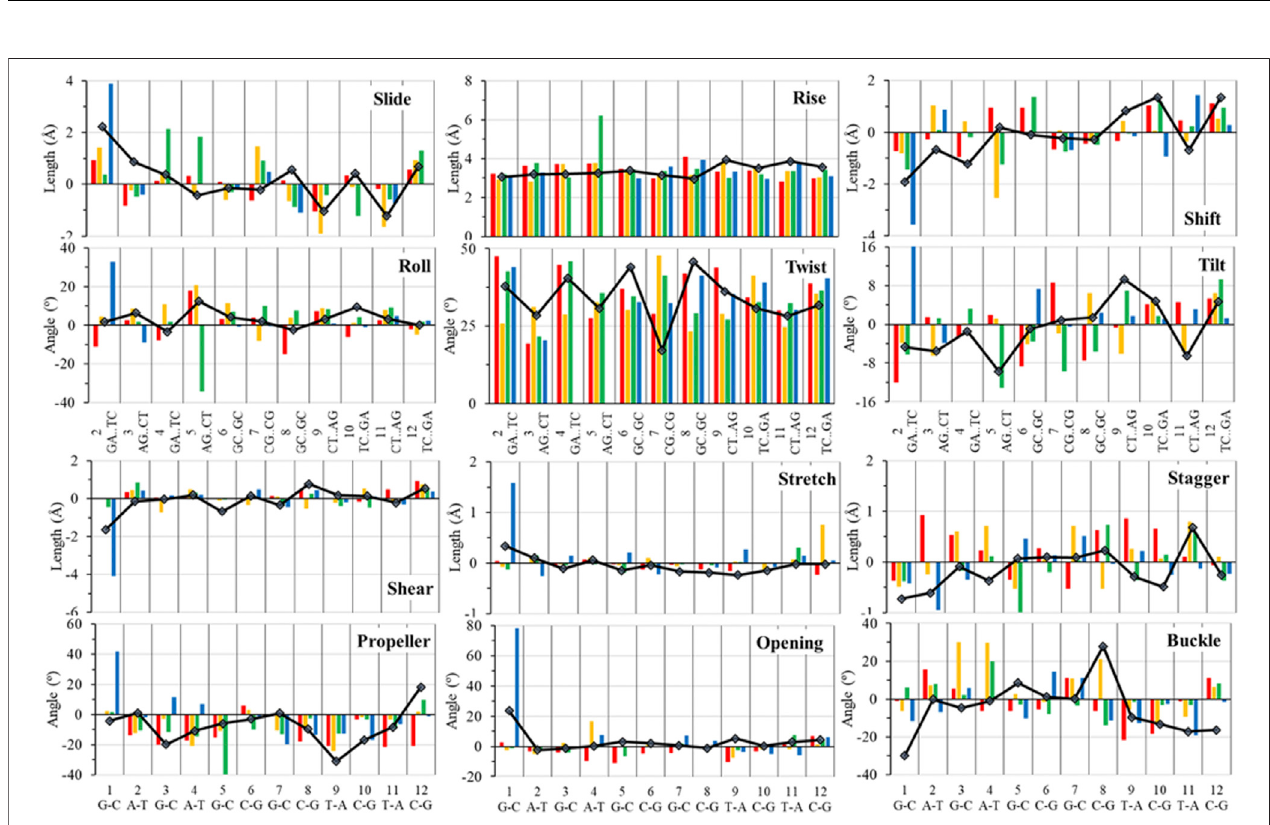
FIGURE 7 | Top 6 panels represent the measure of local DNA helical deformation (calculated using the program 3DNA) with the following base pair parameters: slide, shift, tilt, roll, rise, and twist. The bottom six panels represent the measure of local DNA helical deformation with the following base pair parameters: shear, buckle, stretch, propeller, stagger, and opening. All structures were analyzed after 100 ns of MD simulations; the color scheme is the same as in left of Figure 6 .